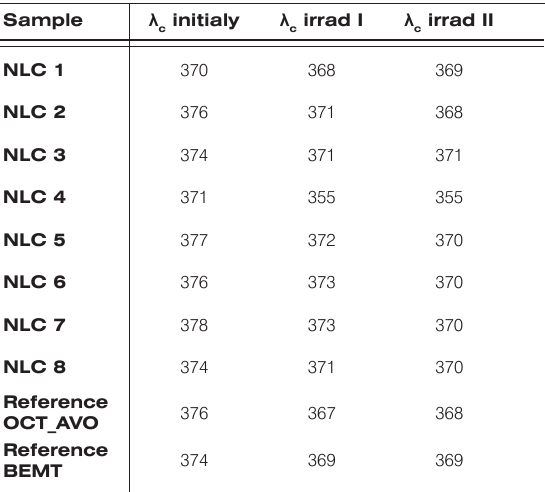
Table 3. The critical wavelength of creams based on NLCs exposed to UV radiation.